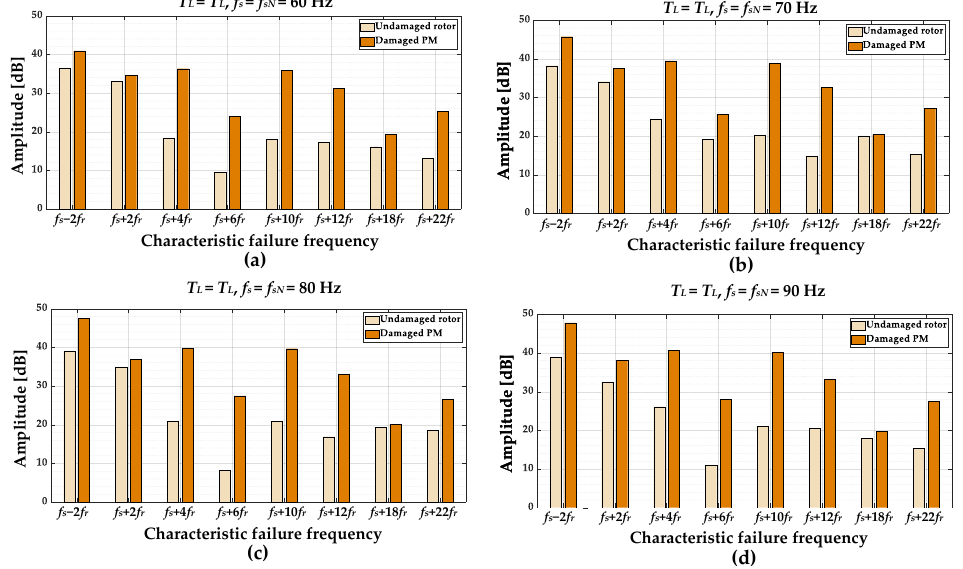
Figure 10. The impact of the damaged PM (partial demagnetization) of the PMSM rotor and f s on the amplitude levels of the frequency component in the stator phase current STFT spectrogram ( a ) f s = 60 Hz, ( b ) f s = 70 Hz, ( c ) f s = 80 Hz, ( d ) f s = 90 Hz.